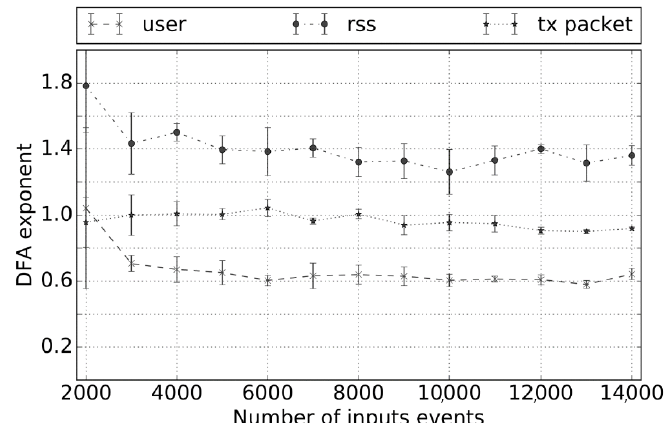
Figure 3. Stability of the DFA exponent for three different metrics: user CPU, resident set size, and transmitted